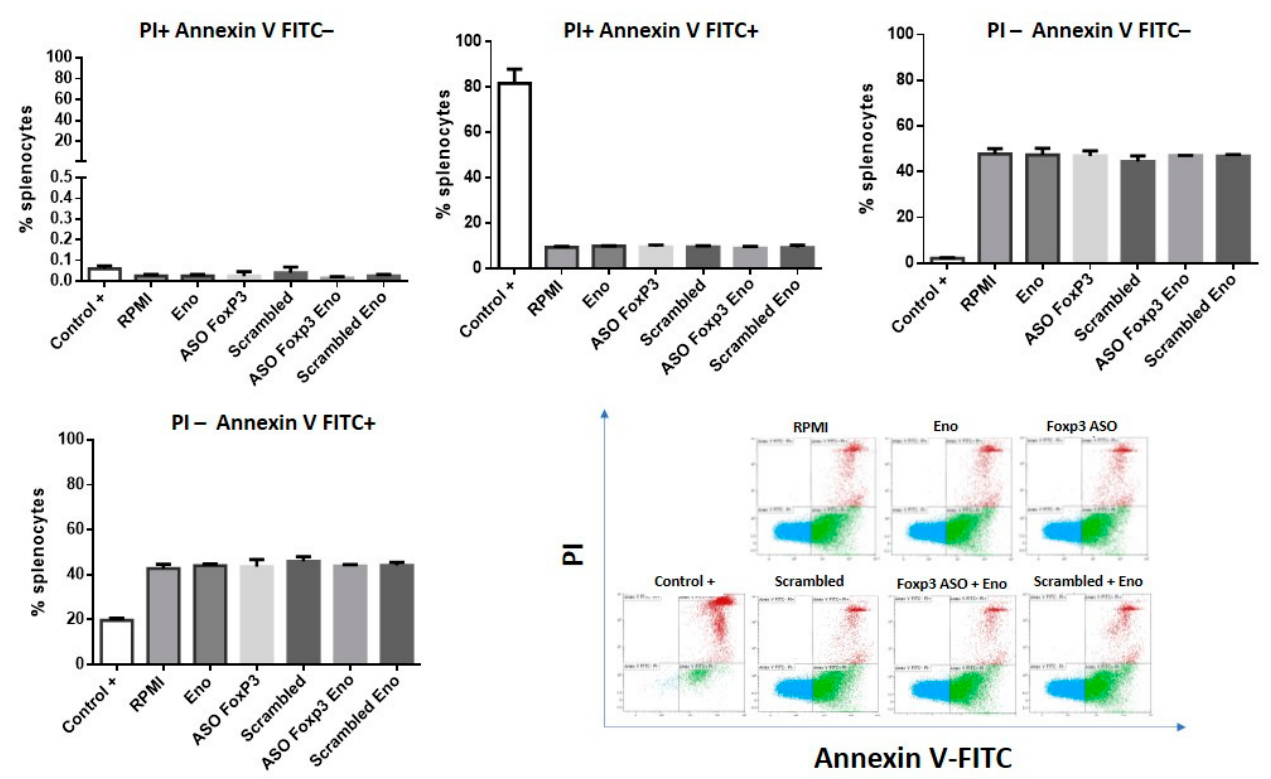
Figure 4. Analysis of variance (ANOVA) with Tukey’s post-hoc test was used. The confidence interval was established at 95% for all tests. There were no significant differences between the experimental groups. A positive heat-killed cell control was used by means of incubation at 56 °C for 30 min.